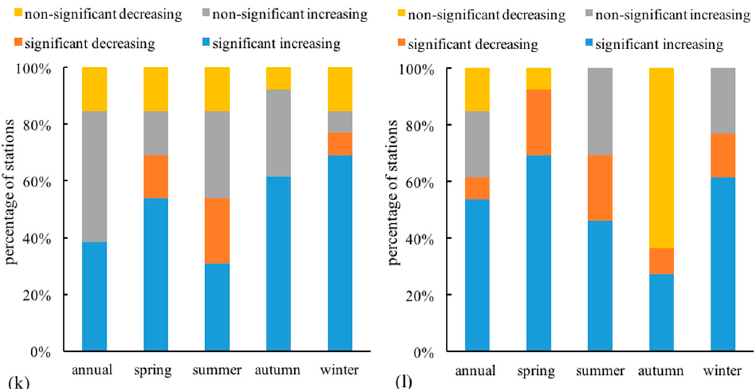
Figure 8. Analysis of the MK trend trest ( a – e , k ) and ITA results ( f – j , l ) for annual and seasonal river runoff at 13 stations in the Lake Issyk-Kul basin. Notes: Cks-Chong-Koi-Suu, Ca-Cholpon-Ata, Cak-Chong-Ak-Suu, Aks-Ak-Suu, Cu-Chong-Uryukty, Pg-Pzhergalan, As-Ak-sai, Ts-Tossor, To-Ton, Dk-Dzhuuku, Tg-Tamga, Kk-Karakol, and Cky-Chong-Kyzyl-Su. Table 5 summarizes the results of the ITA method for “low”, “medium”, and “peak.” As presented in Table 5, the “low”, “medium”, and “peak” values of all 13 river stations were individually evaluated by the ITA method. As provided in Table 2, there is trendless (no trend) in annual and seasonal data series according to the MK test, but increasing and decreasing trends are seen with the ITA method (Table 5). The ITA method results revealed that increasing trends occurred in 89 of the 195 data series at the 13 hydrological stations (45.64%), while decreasing trends were found in 15 data series (7.69%). In comparison, 24 data series (26.97%) exhibited increasing patterns for “peak” river runoff, 25 data series (28.09%) displayed increasing patterns for “low” river runoff, and 40 data series (44.94%) showed increasing patterns for “medium” river runoff. According to the “low”, “medium”, and “peak” river runoff, five data series (33.33%), seven data series (46.67%), and three data series (20%) manifested downward trends, respectively. These results provided detailed information concerning the annual and seasonal river runoff patterns by evaluating the “low”, “medium”, and “peak” values. Table 5. Results of the ITA method for annual and seasonal river runoff in the “low”, “medium”, and “peak” in the Lake Issyk-Kul baisin (1943–2012). Stations Annual Spring Summer